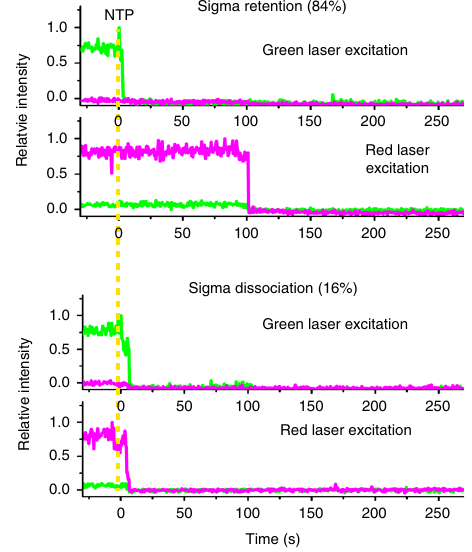
Fig. 3 Retention of σ 70 factor. An L + 15 derivative complex with Cy5 (magenta dot) placed on σ 70 factor (light grey oval) and with Cy3 (green dot) labeled on the 5 ′ -end of transcript RNA (dark grey line) is immobilized through biotin (black dot). Retention of Cy5- σ on DNA after termination (upper trace) occurs more frequently than its dissociation from DNA (lower